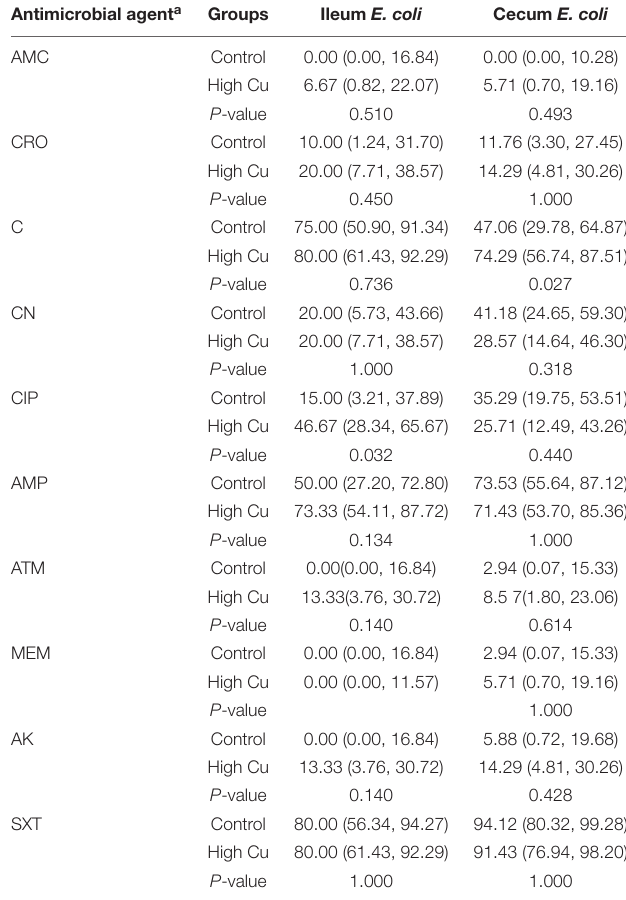
TABLE 4 | Antimicrobial resistance rates (95% CI) of Escherichia coli in ileum and cecum 1 . Antimicrobial agent a Groups Ileum E. coli Cecum E.